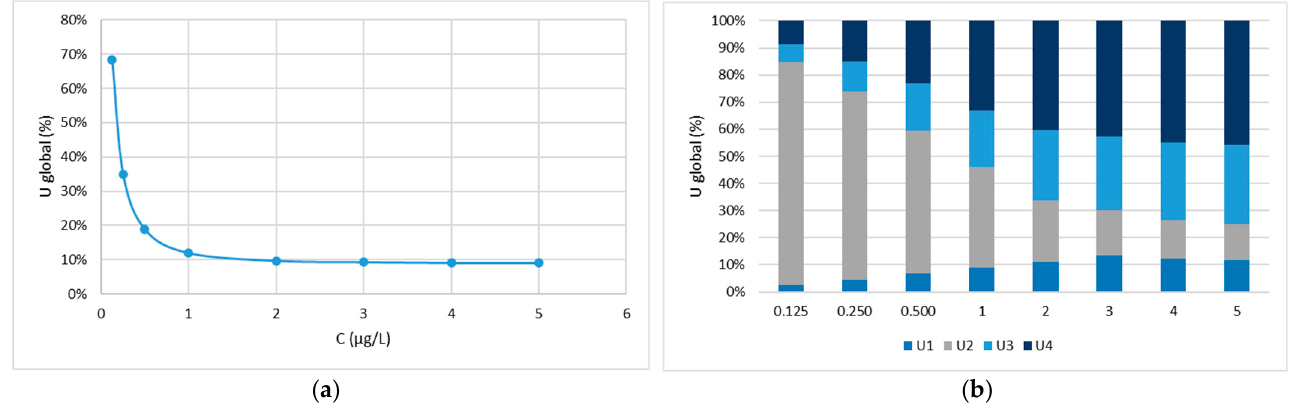
Figure 4. Global uncertainty of D 5 ( a ) and variation of the relative weight of each individual source of uncertainty for D 5 ( b